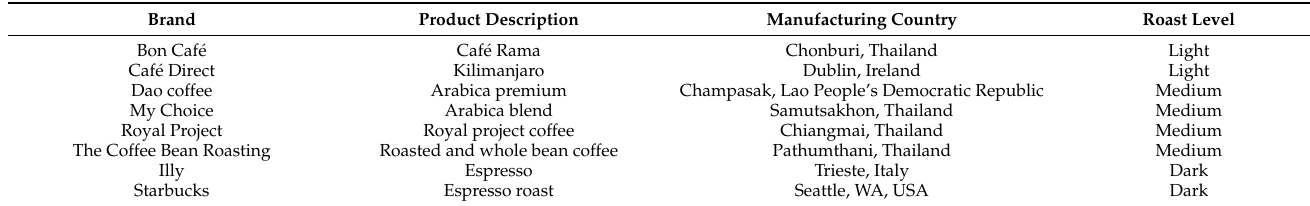
Table 1. A list of eight Arabica roasted coffee bean samples evaluated in the study. Brand Product